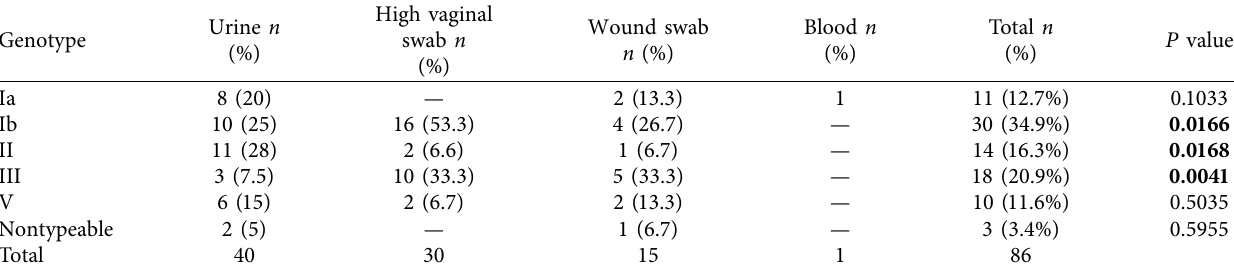
Bold values represent the statistically signifcant association between the genotype and the clinical